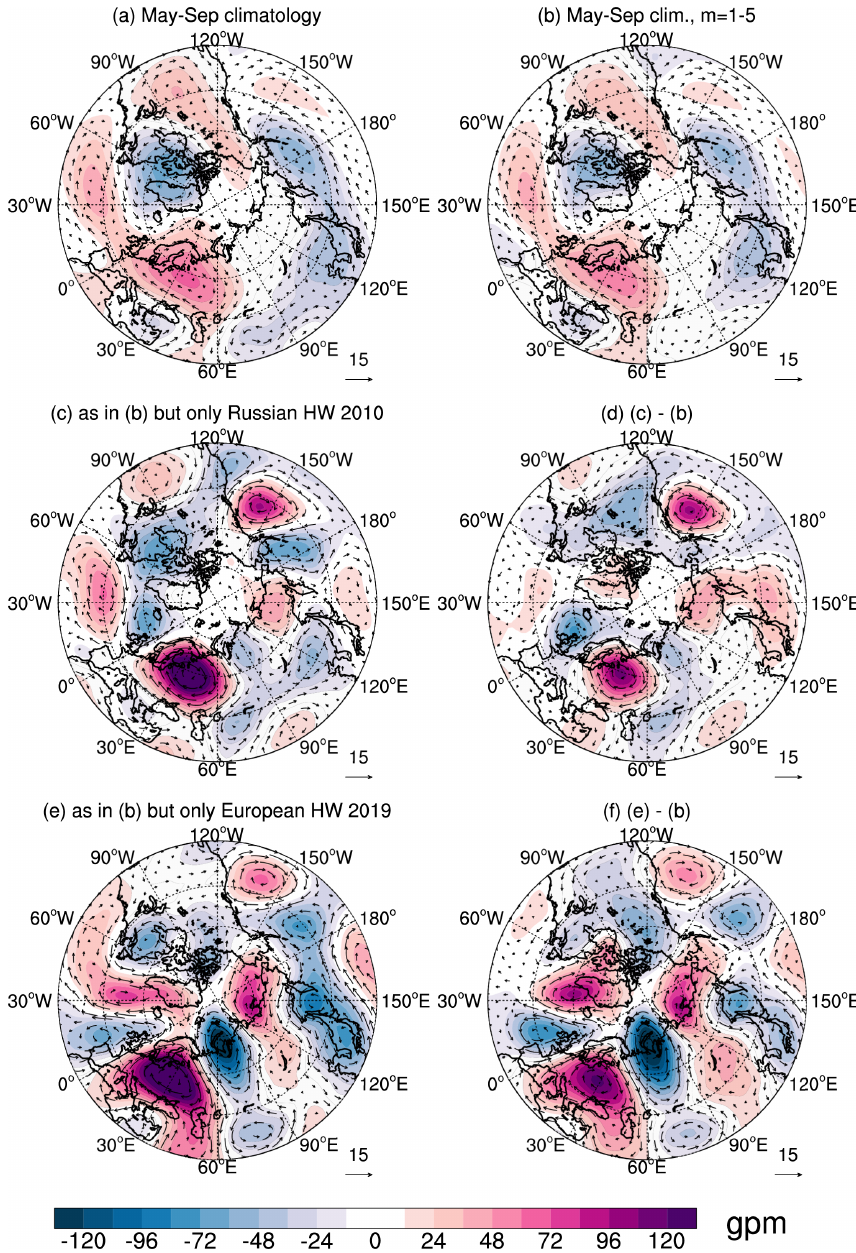
Figure 3. (a, b) Climatological Rossby wave circulation for extended boreal summer (MJJAS) at the σ level close to 500hPa in the mid- latitudes. (a) All zonal wavenumbers k > 0, all meridional modes n and all vertical modes m are included. (b) As in panel (a) , but only troposphere–barotropic vertical modes, m = 1–5. (c) As in panel (b) but for the Russian heat wave (HW) in 2010. (d) Difference between panels (c) and (b) . (e) As in panel (b) and panel (f) is as in panel (d) but for the European HW in 2019. Coloured contours are geopotential height anomalies (in gpm). The wind speed is shown by the length of the wind vectors (with 15ms − 1 as a reference